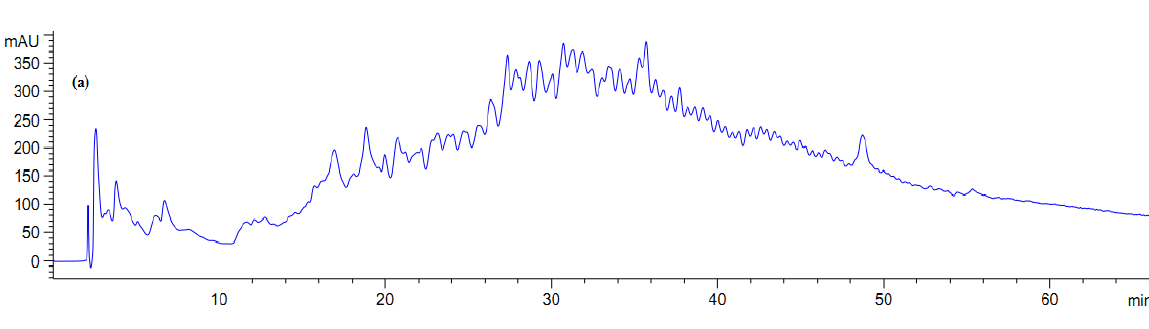
Figure 4. Fractionation of A. lecanora bromelain generated hydrolysate (after 1 h hydrolysis) by semi-preparative RP-HPLC. ( a ) Chromatogram of A. lecanora hydrolysate; ( b ) Growth inhibition (%) of collected fractions against P. aerogeniosa ; and ( c ) Growth inhibition (%) of collected fractions against Pseudomonas